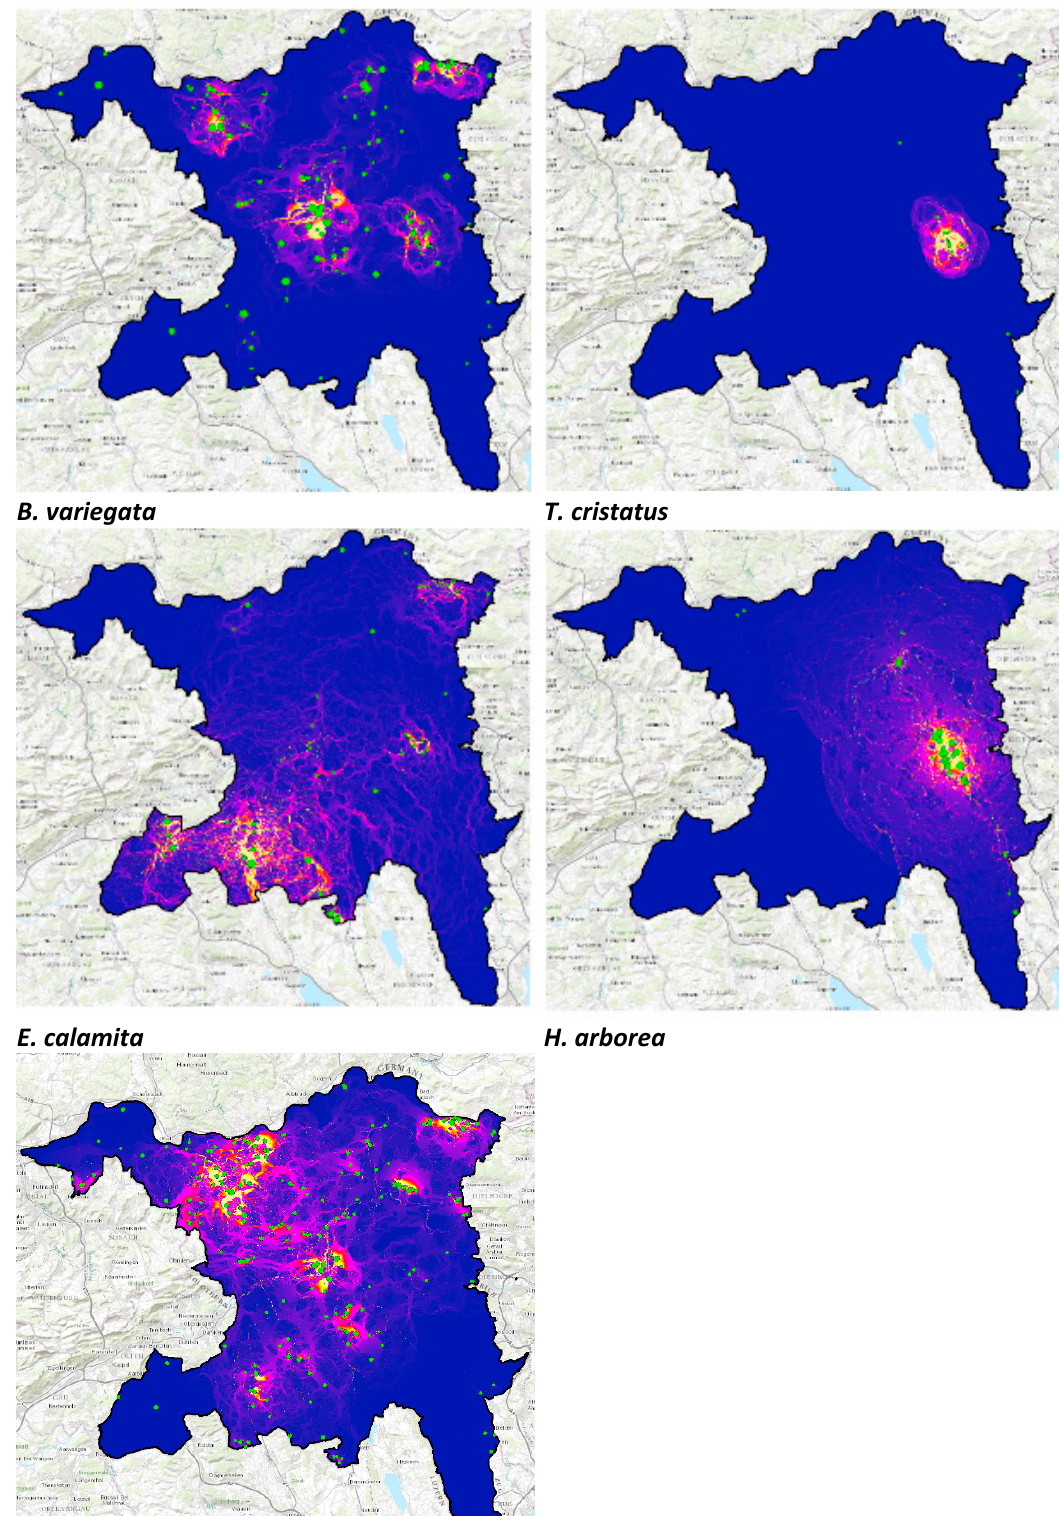
Appendix B: Functional connectivity maps for Bombina variegata, Triturus cristatus, Epidalea calamita, Hyla arborea , and Alytes obstetricans. The green circles indicate the locations of breeding sites.